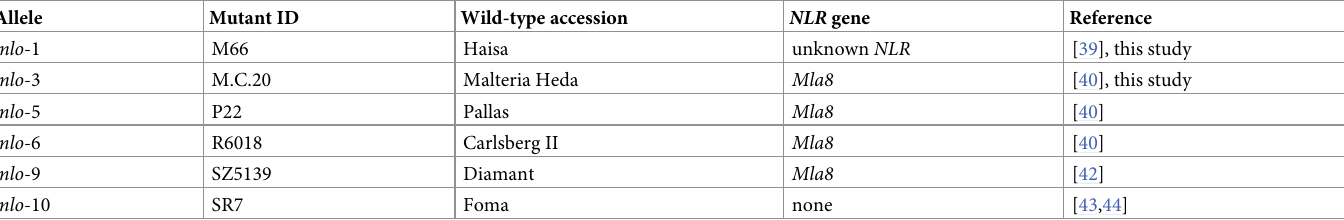
Table 1. NLR gene (s) against Blumeria graminis f. sp. hordei isolate RACE1 in mlo mutant alleles.